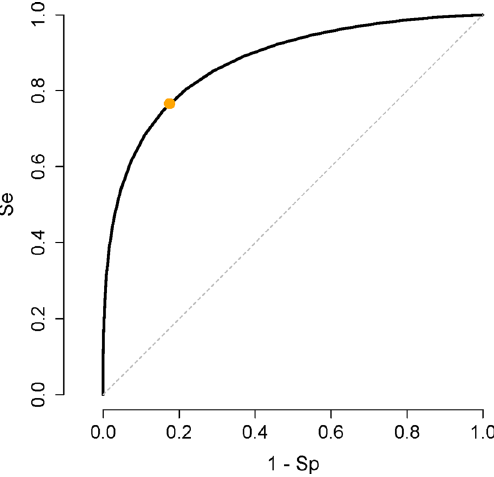
Figure 4. ROC curve for 54–59-year-old men. The curve is constructed based on subset analysis of 54–59-year- old men. The area under the curve is 0.874. The orange solid circle corresponds to the most appropriate cut-off value for PSA, 1.61 ng/mL, a point maximizing the Youden’s index (corresponding to a relative cost of a false- negative to a false-positive test result of 4), corresponding to a Se and Sp of 76.6% and 82.5%,